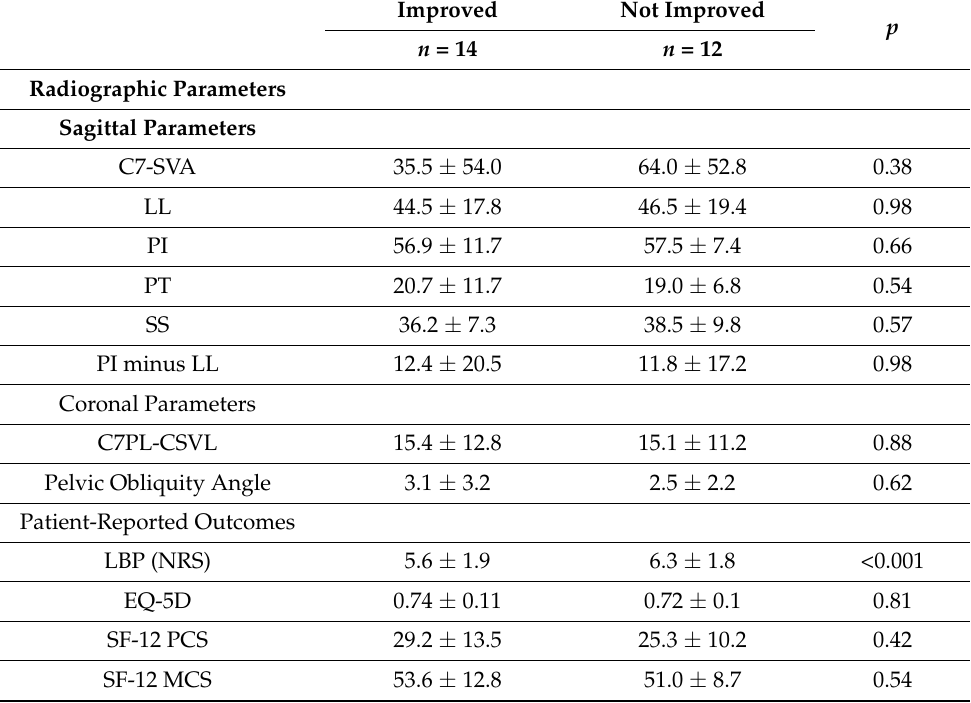
Table 3. Comparison of preoperative radiographic parameters and patient-reported outcomes in patients with preoperative lower back pain (improved vs not